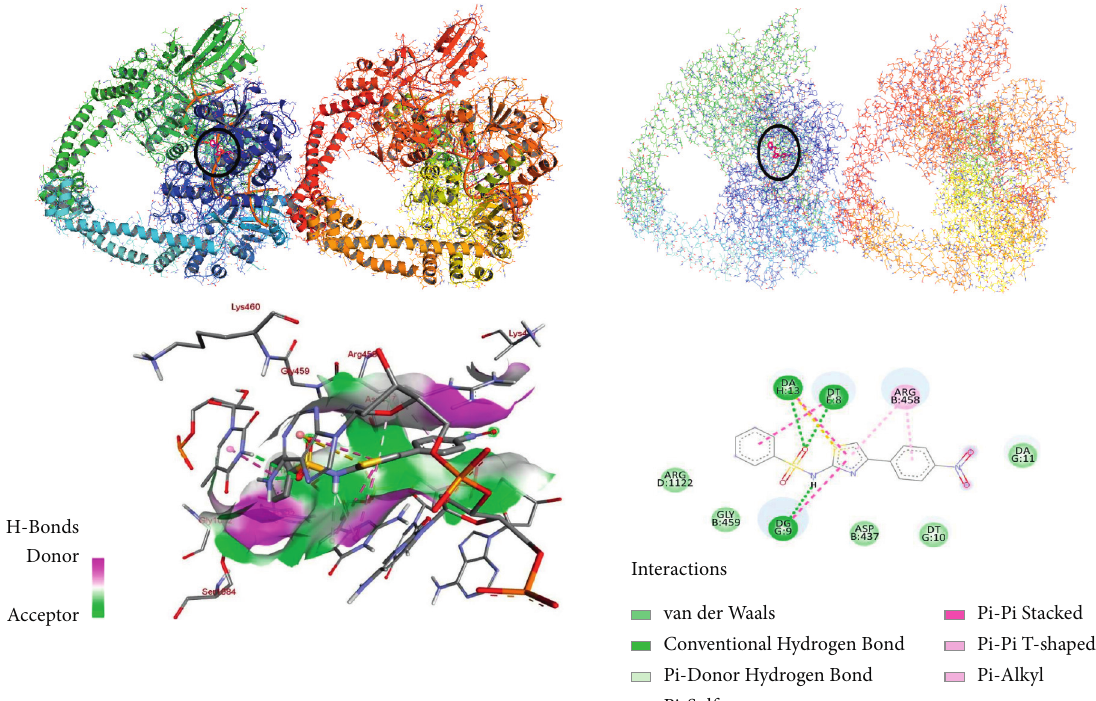
Figure 4: The 2D and 3D binding interactions of compound 11b against S. aureus gyrase (PDB ID: 2XCT). 3D ribbon and line models show the binding pocket structure of S. aureus gyrase with compound 11b . Hydrogen bonds between compounds and amino acids are shown as green dashed lines, and hydrophobic interactions are shown as pink/purple lines. Electrostatic interaction is shown as orange